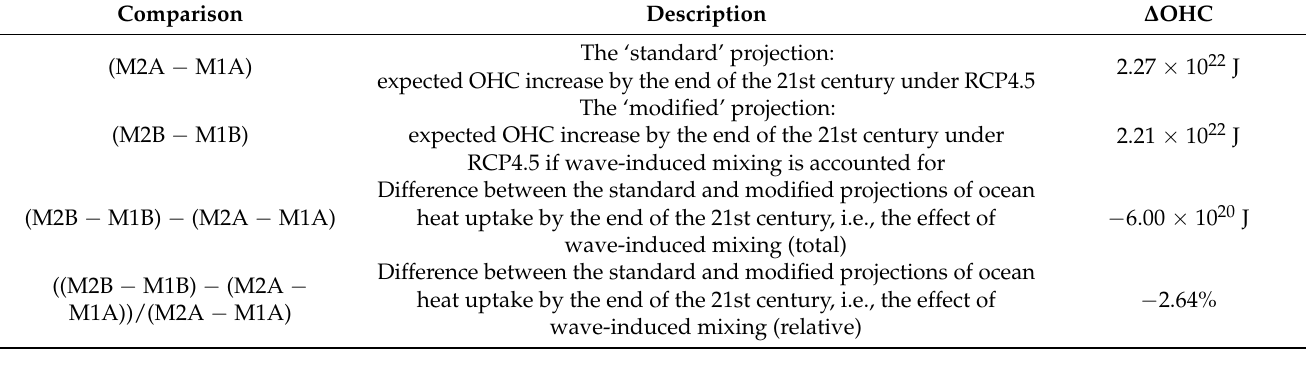
Table 3. Projections of changes in Ocean Heat Content (OHC) for the future climate period. OHC is the mean heat content within the upper 200 m of the ocean.